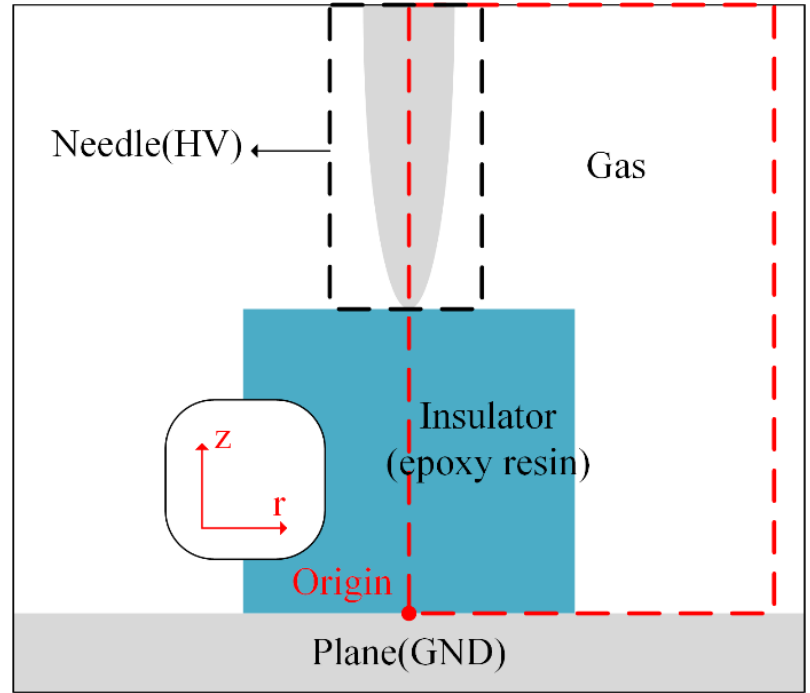
Figure 1. The geometry of the model (HV: high voltage; GND: grounded).